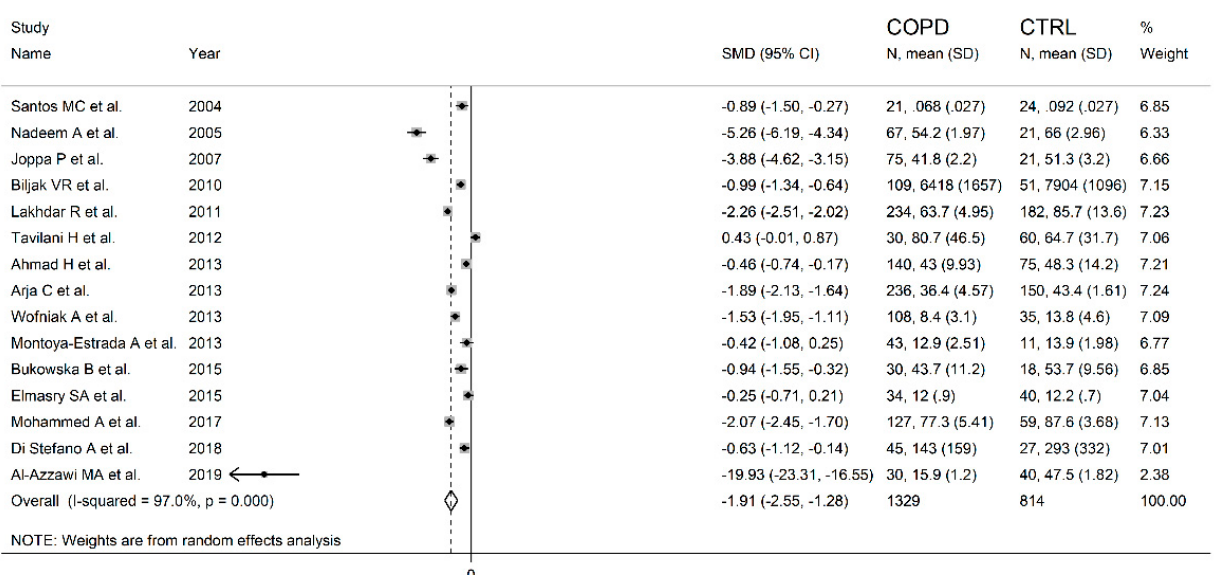
Figure 3. Sensitivity analysis of the association between blood/erythrocytes GPx and COPD disease. For each study, the displayed effect size (hollow circles) corresponds to an overall effect size com- puted from a meta-analysis excluding that study.